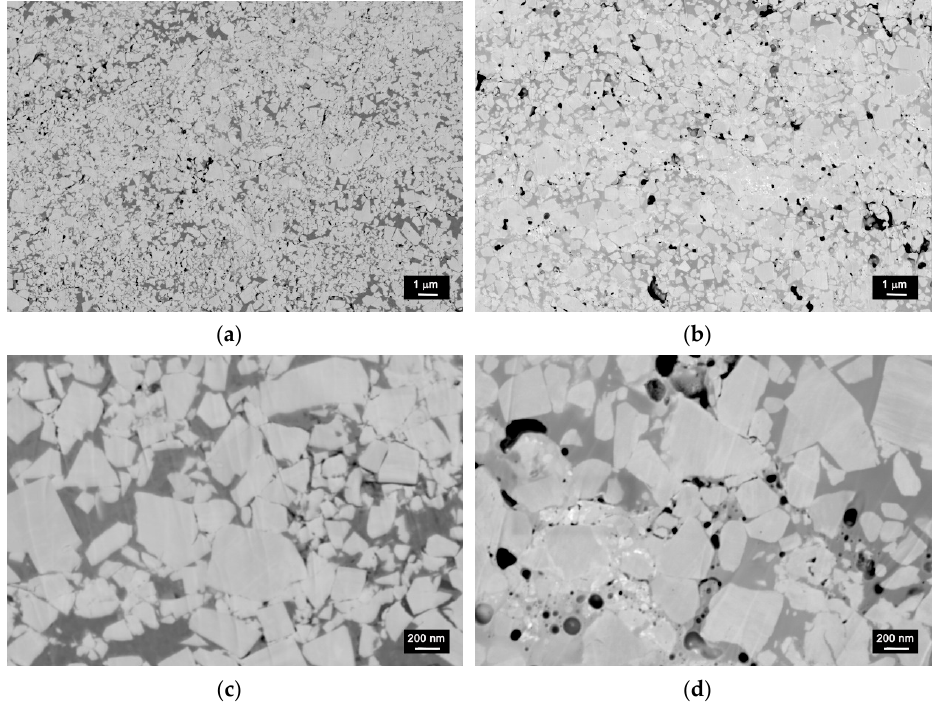
Figure 4. Microstructure of ( a , c ) CGS and ( b , d ) HVAF WC-12Co coatings.